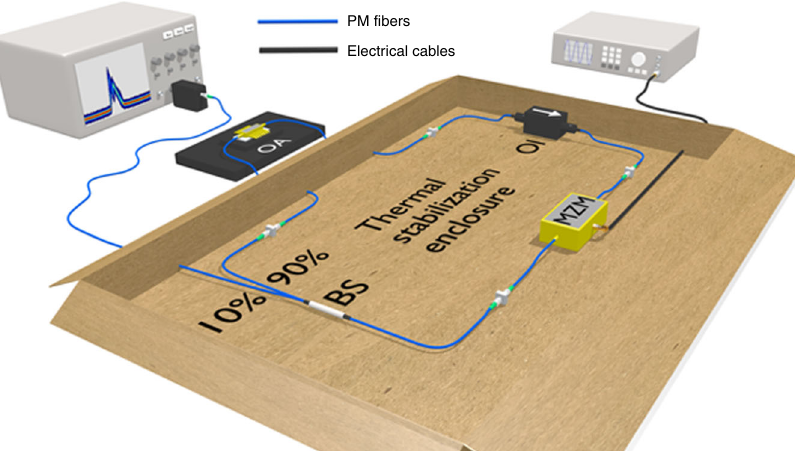
Fig. 2 Experimental setup. The actively modelocked laser is based on an antire fl ection coated semiconductor optical ampli fi er operated in a closed loop including an optical diode for unidirectional operation, an intensity modulator and a low transmission fi ber beam splitter allowing signal detection. OA fi ber- coupled semiconductor ampli fi er, PM single mode polarization-maintaining fi ber, OI optical isolator, MZM Mach-Zehnder lithium niobate intensity